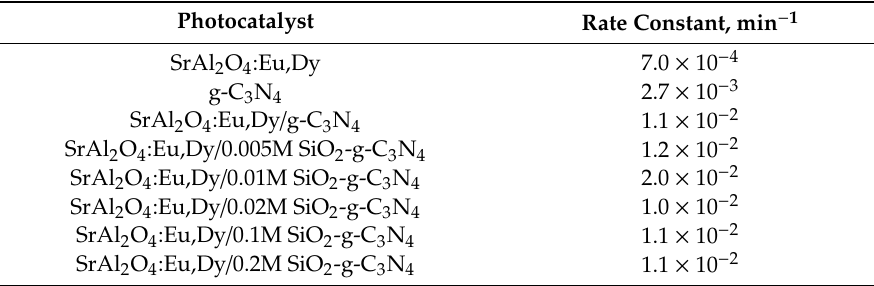
Table 4. Rate constants for UV-light